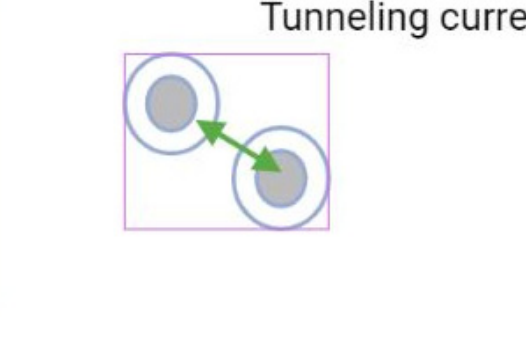
Figure 5. Thetunnelling effect.